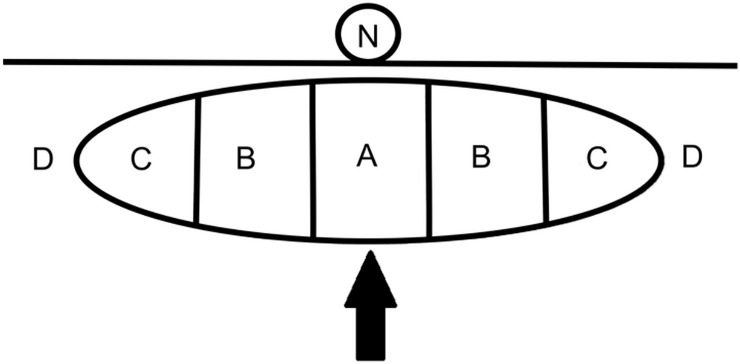
The relationship of a mass to a nipple.The mass (arrow) is divided into five parts of equal width. When part A is located below the center of a nipple, it is classified as concentric to the nipple, as in this example. When part B is below the nipple, it is classified as mildly eccentric to the nipple. If part C is below the nipple or the mass is in area D and not below the nipple at all, it is classified as markedly eccentric to the nipple.